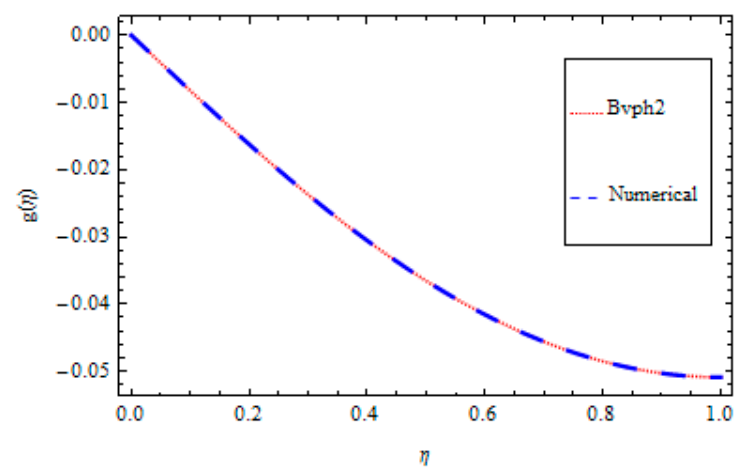
Figure 4. Graphical comparison of the HAM and numerical solution.